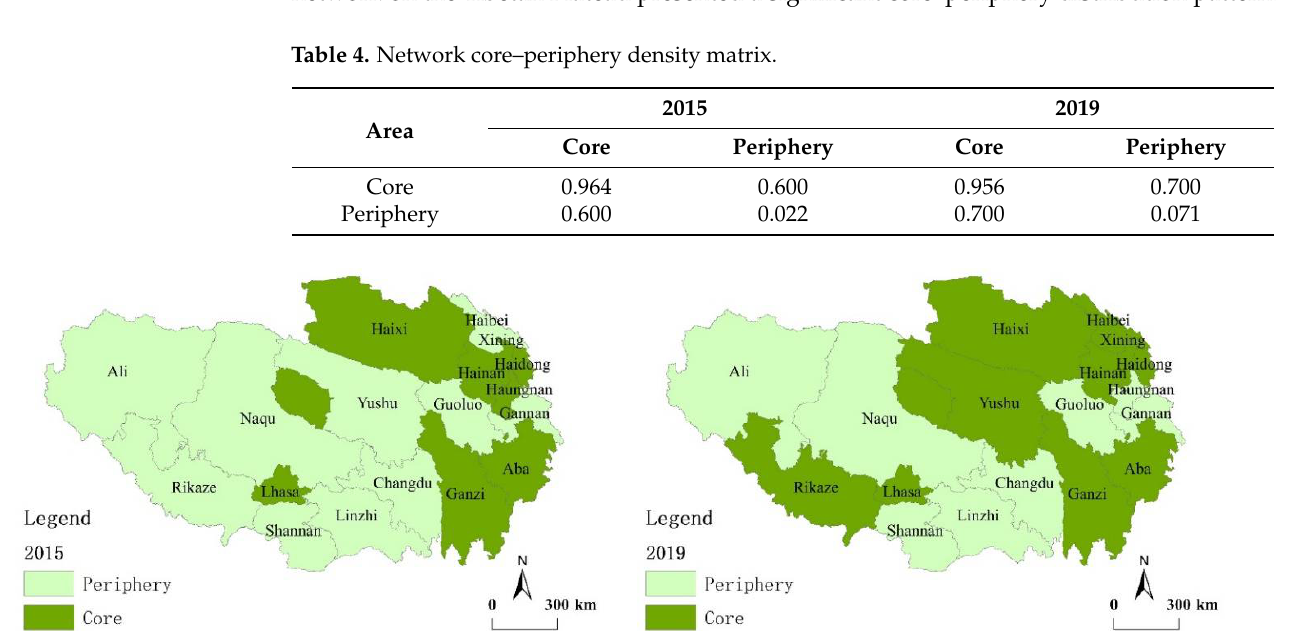
Table 4. Network core–periphery density matrix.